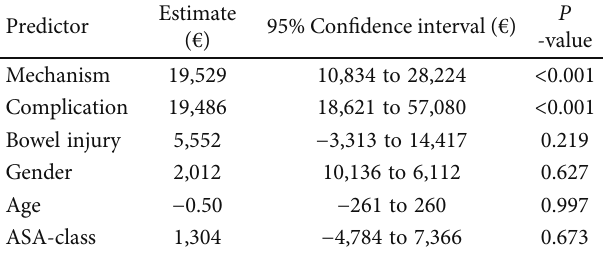
Table 1: Multivariable linear regression analysis of total costs